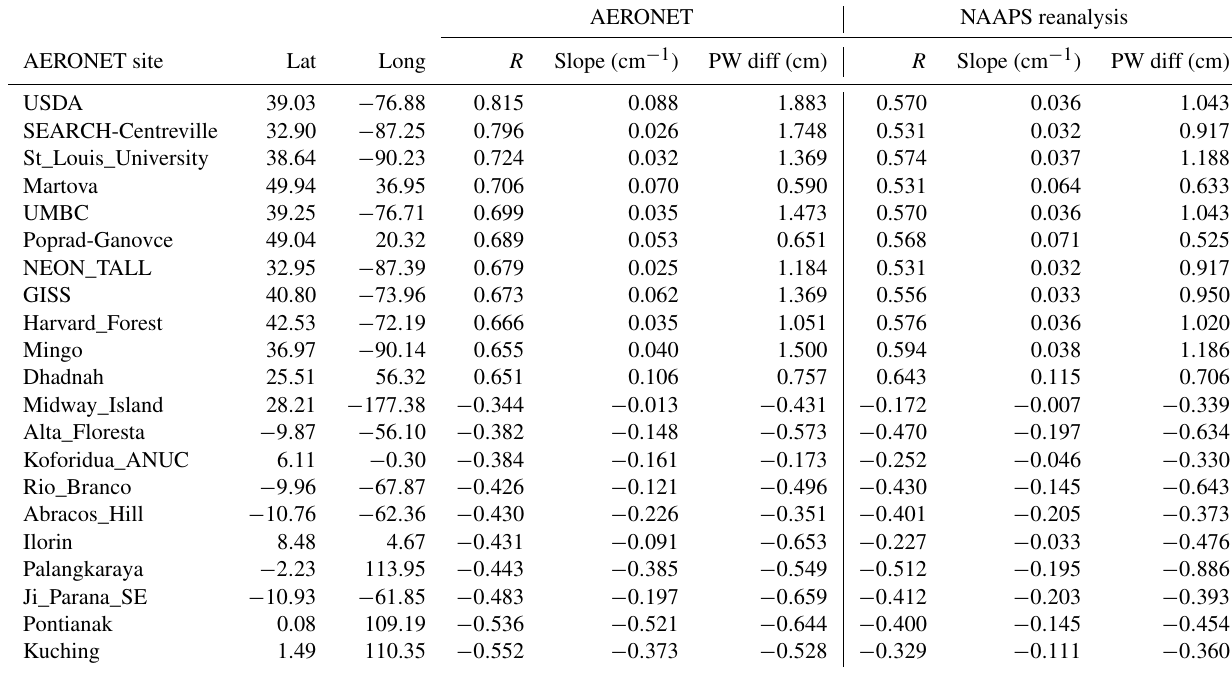
Table 4. AOD and PW relationship evaluation results for SON at select AERONET sites that exhibited the strongest AERONET correlations, positive and negative. The site name and latitude–longitude information are shown, as well as the correlation ( R ), the change in AOD with PW (slope), and the statistically significant difference in mean PW for high-AOD events (PW diff) for both AERONET and the NAAPS-RA. PW difference values of 0 in the NAAPS-RA indicate the change was not statistically